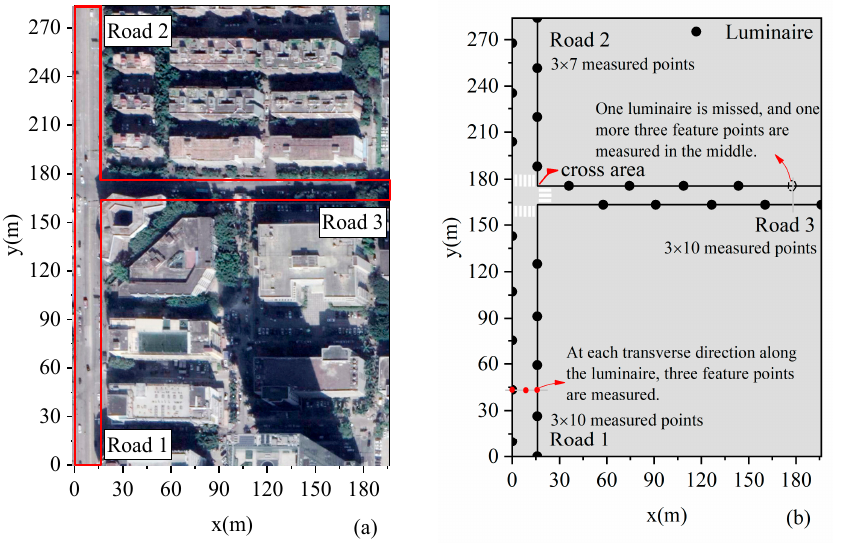
16 m, Road 2, 100 m × ×